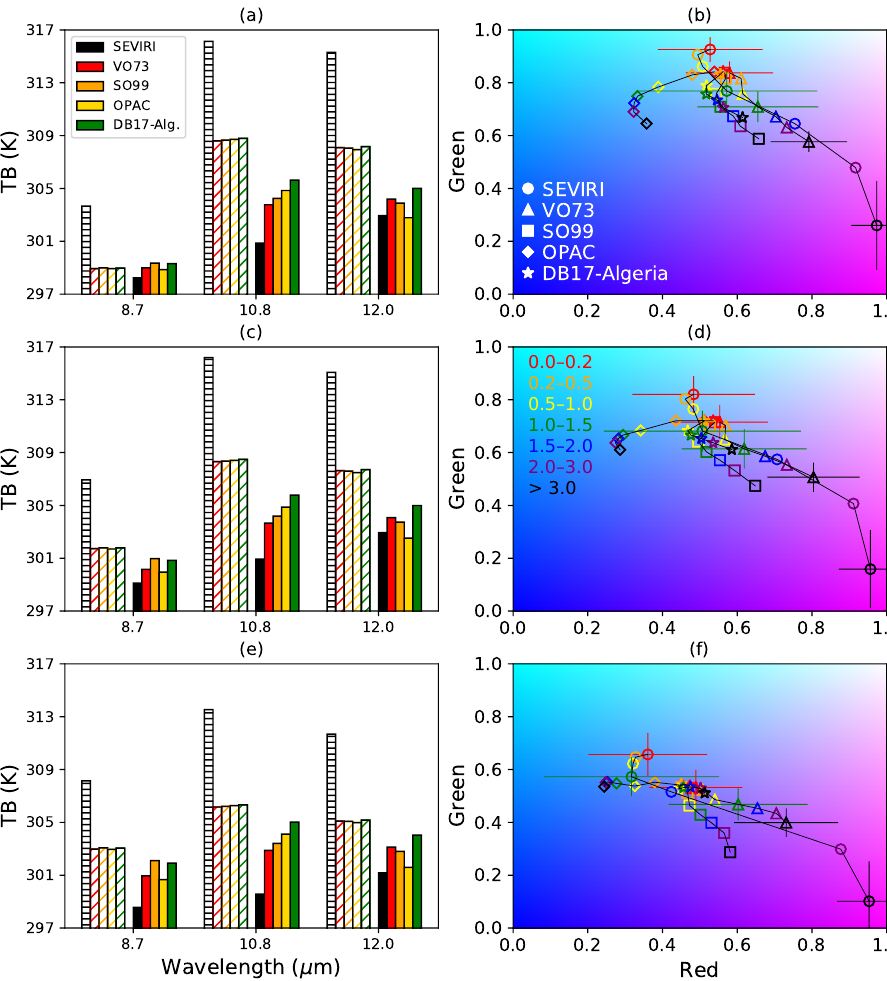
Figure 10. Mean brightness temperatures and colours across the domain for three ranges of surface emissivity values, for the SEVIRI measurements and retrievals and four of the dust simulations, for the June and July of 2011–2013. Using emissivity at 8.7µm, the panels are: (a, b) emissivity from 0.7 to 0.8; (c, d) 0.8–0.9; (e, f) 0.9–1.0. The simulated dust is spherical. Per panel of brightness temperatures (left column), within each individual wavelength set there are two groups of bars: the striped bars on the left are points with AODs between 0 and 0.2 (i.e. the most pristine-sky case); the bold bars on the right are points with AODs between 2 and 3. The mean colours (right column) are plotted within specified AOD ranges denoted by the coloured symbols: red is 0–0.2; orange is 0.2–0.5; yellow is 0.5–1; green is 1–1.5; blue is 1.5–2; purple is 2–3; black is > 3. This colour coding is also marked in panel (d) . The blue beam is held fixed at 1. Error bars denoting the standard deviations of the mean values are only included, for clarity, for three of the SEVIRI and the VO73